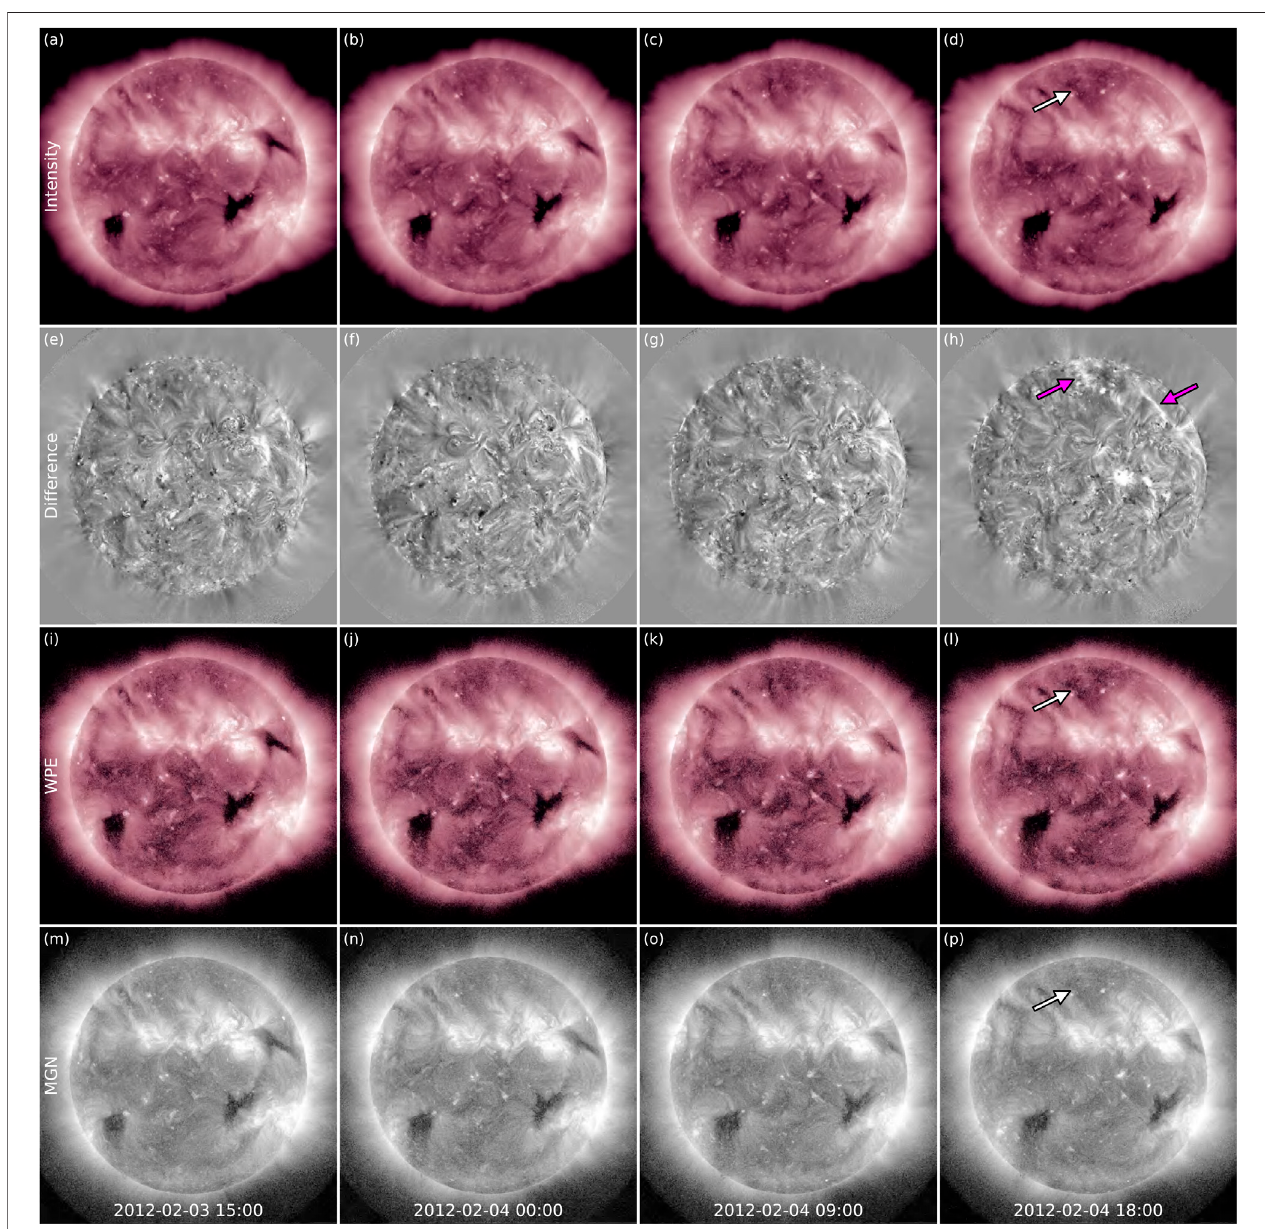
FIGURE 5 | Imaging techniques applied to the 2012 February 4 CME (Event 3). SDO/AIA 211Å images are shown at four different times and processed with four different methods. (A – D) Intensity images. (E – H) Difference images with fi xed Δ t (cid:2) 12 h. (I – L) WPE-processed images. (M – P) MGN-processed images. Dimming and brightening regions are indicated with arrows (see text for